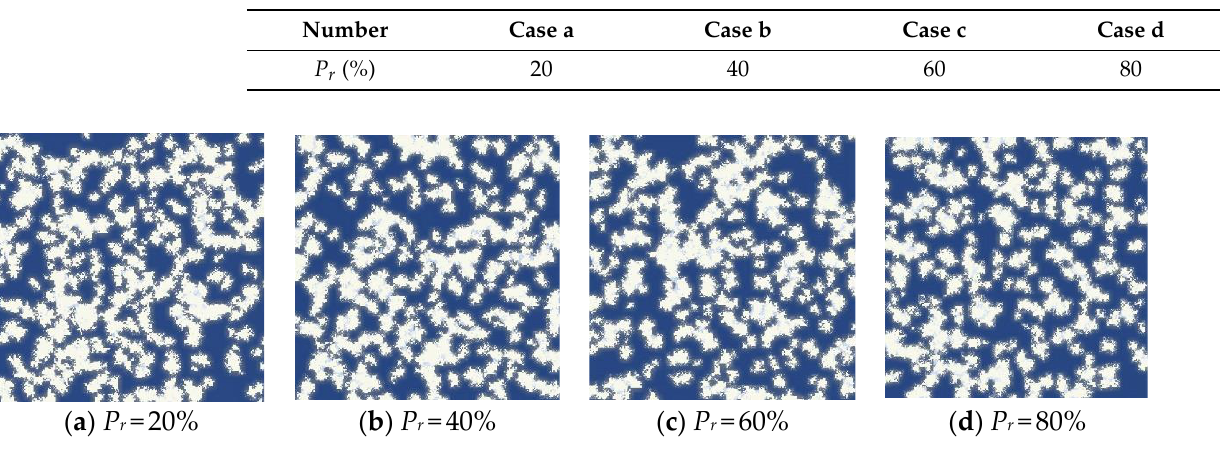
Table 3. The proportion of HD C-S-H in different cases.